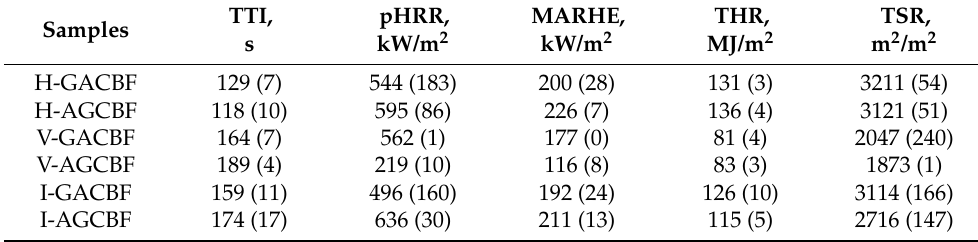
Table 2. Cone calorimeter results of hybrid composites.